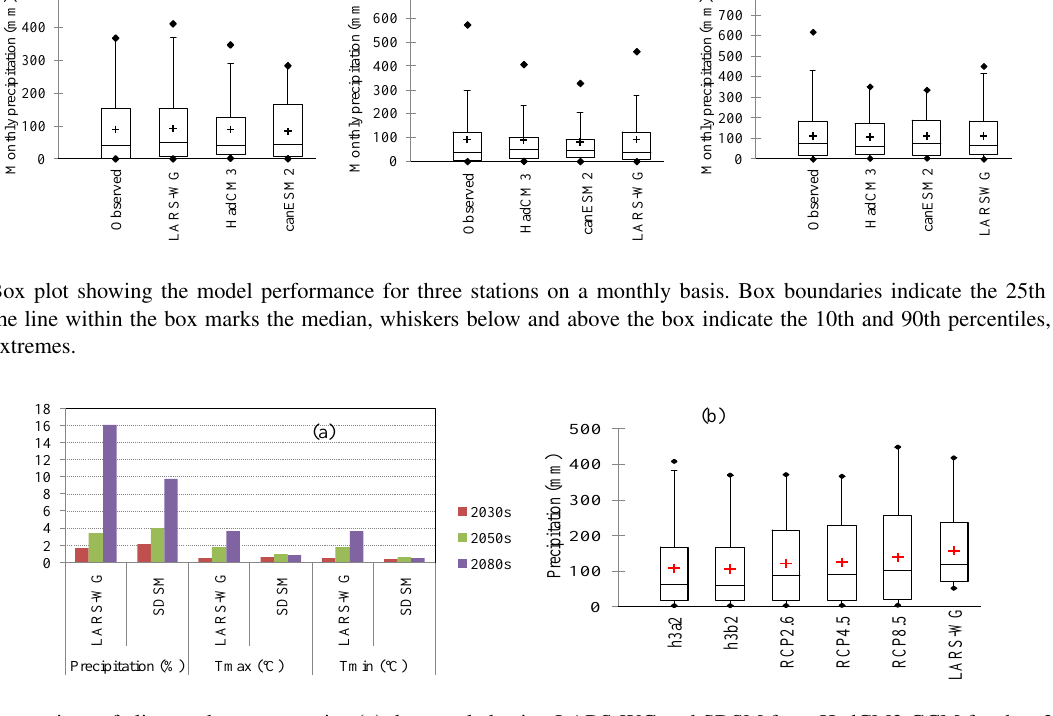
Figure 11. Comparison of climate change scenarios (a) downscaled using LARS-WG and SDSM from HadCM3 GCM for the a2 scenario and (b) downscaled from different scenarios (LARS-WG using hadCM3 a2 scenario).